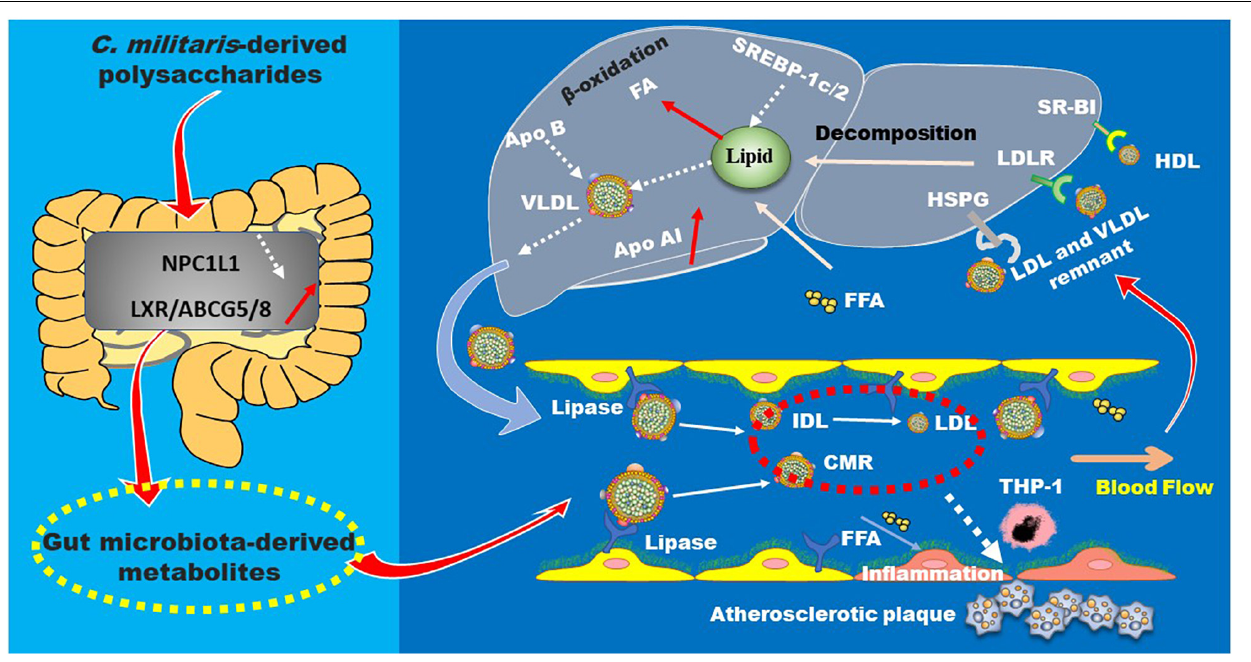
FIGURE 9 | The lipid-lowering mechanisms of C. militaris -derived polysaccharides. These polysaccharides are found to modulate multiple genes and proteins related to lipid absorption and metabolism in the plasma, small intestine, and liver, thereby improving hyperlipidemia and atherosclerosis. ABC, ATP-binding cassette; Apo, apolipoprotein; CRM, chylomicron remnant; FFA, free fatty acid; HSPG, heparan sulfate proteoglycan; IDL, intermediate density lipoprotein; LDL, low-density lipoprotein; LDLR, low-density lipoprotein receptor; LRP1, LDLR-related protein 1; LXR α , liver X receptor α ; NPC1L1, Niemann-Pick C1-like protein 1; SR-B1, scavenger receptor B type 1; SREBP, sterol regulatory element-binding protein; VLDL, very low-density